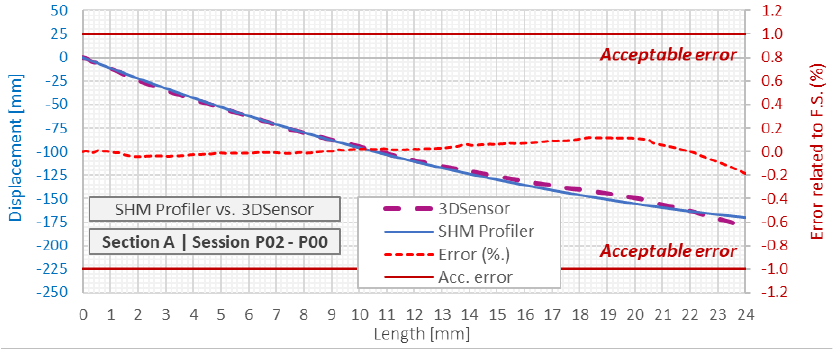
Figure 21. Displacements profiles indicated by hydraulic SHM profiler and DFOS 3DSensor with error analysis relative to the full scale of pressure transducers.